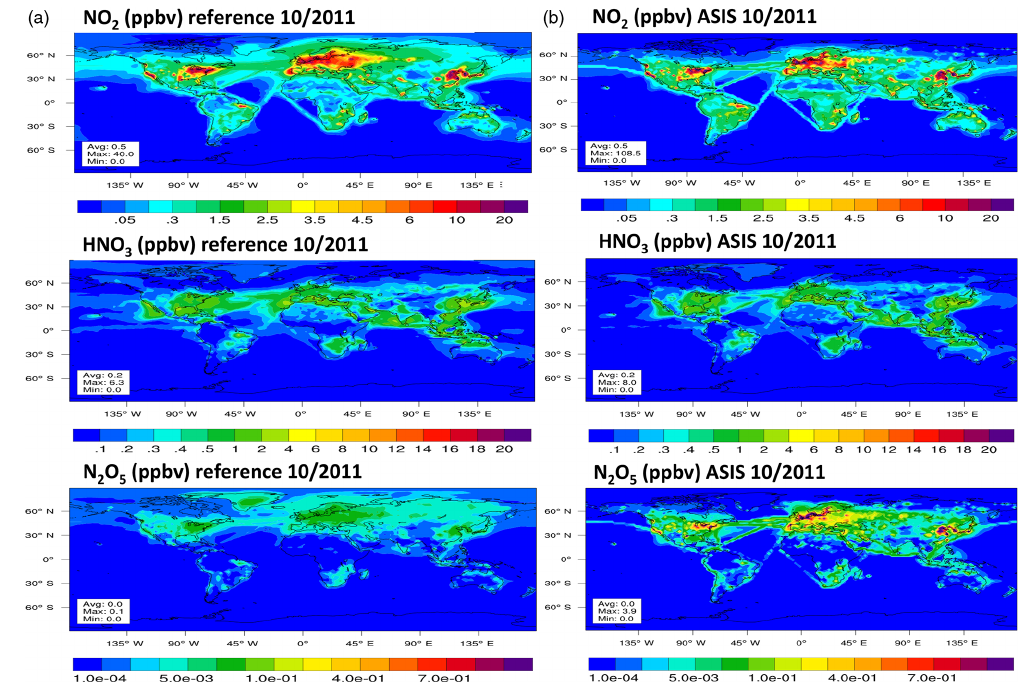
Figure 7. Monthly mean distributions of NO 2 , HNO 3 , and N 2 O 5 at the surface for the month of October after a 2 month integration. The panels in (a) show results of the reference simulation, MR; those in (b) show results of the MA simulation with the use of the ASIS solver. The MR simulation underevaluates the N 2 O 5 in the lower troposphere.